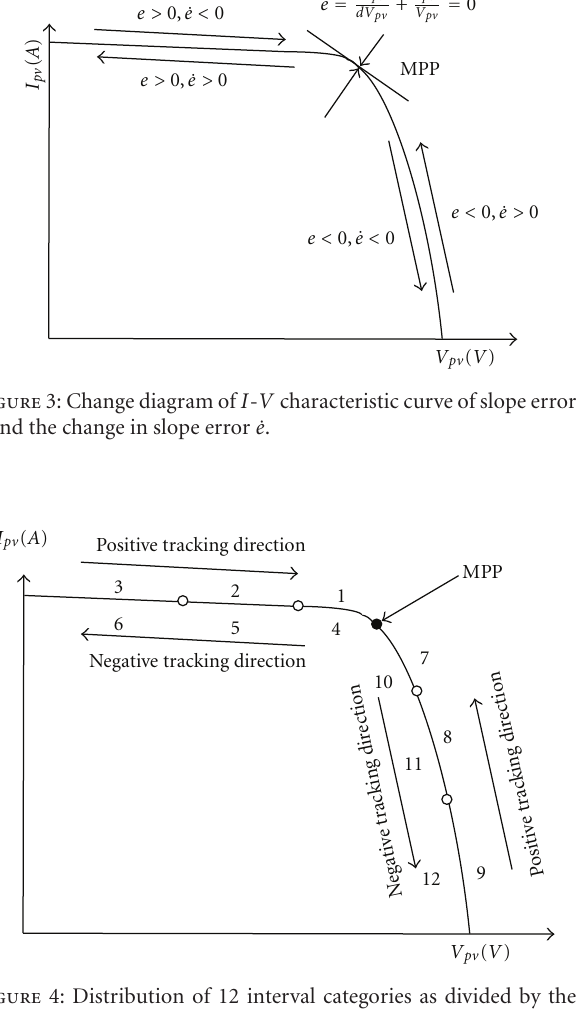
Figure 4: Distribution of 12 interval categories as divided by the I - V characteristic curve.